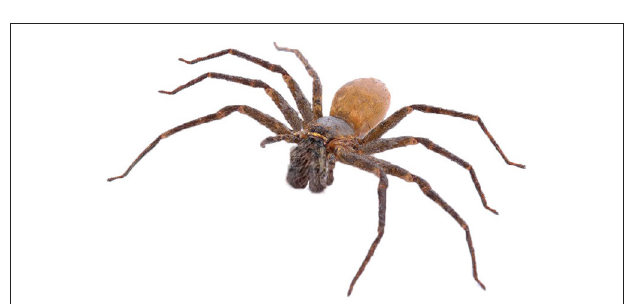
FIGURE 3 | Experimentally manipulated chelicerae of spider.